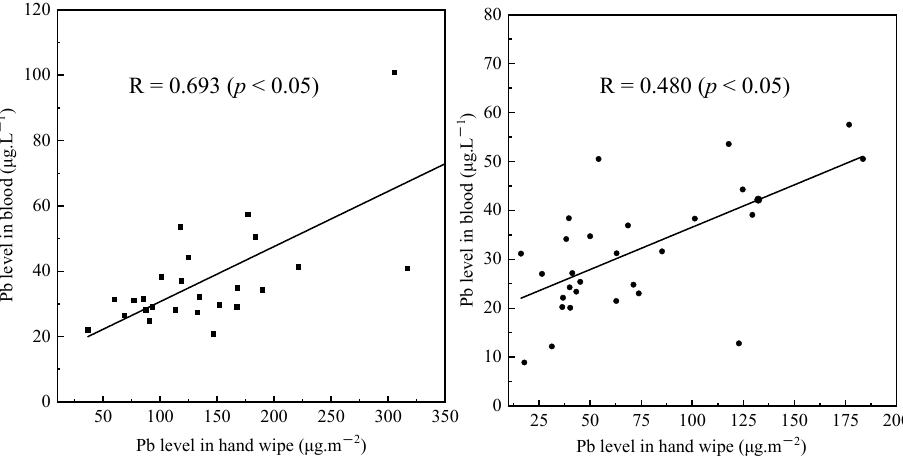
Figure 4. Correlations of Pb level in hand wipe and blood (left: children aged 3–6 years; right: children aged 7–12 years).